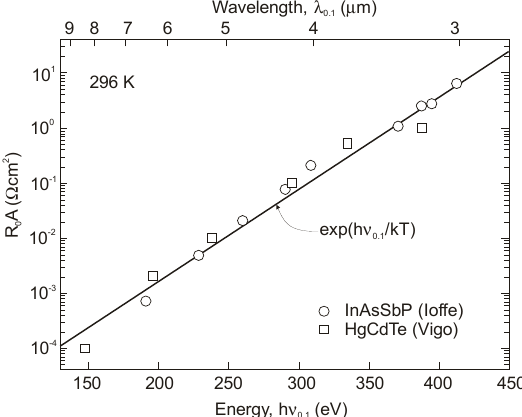
Figure 37. R o A product in series of InAsSb DH at room temperature (after [127]).